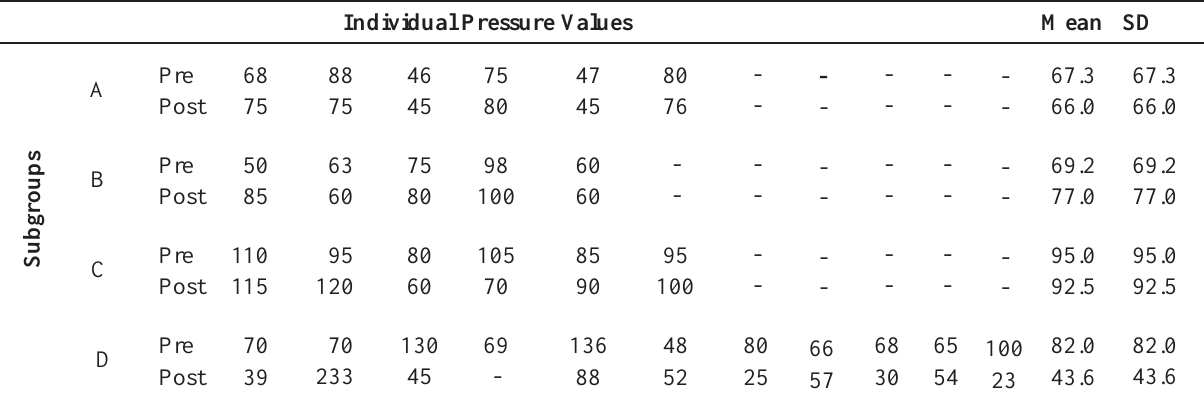
O before and following subcutaneous administration of 2